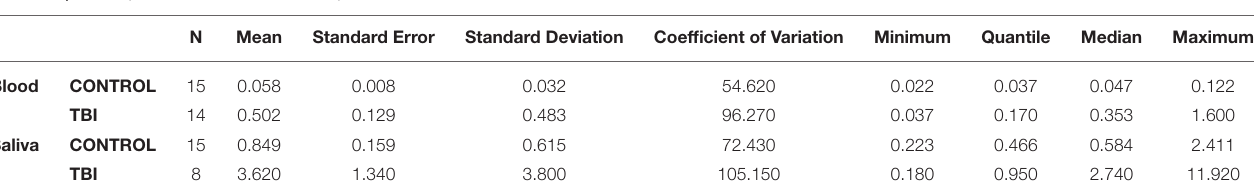
TABLE 2 | Data reported as median and interquartile values. N Mean Standard Error Standard Deviation Coefficient of Variation Minimum Quantile Median